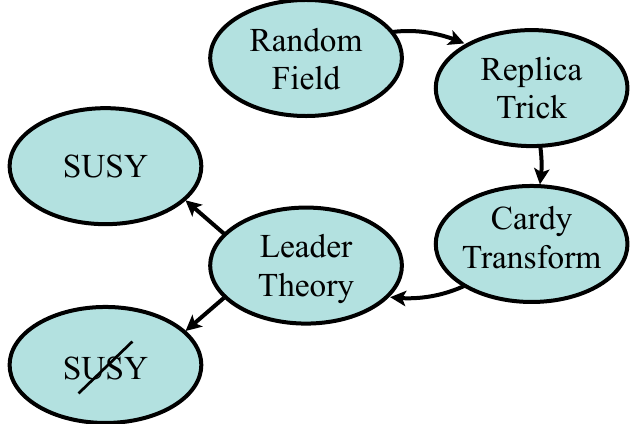
Figure 1 . A flowchart summarizing the RG framework of [1] for a random field